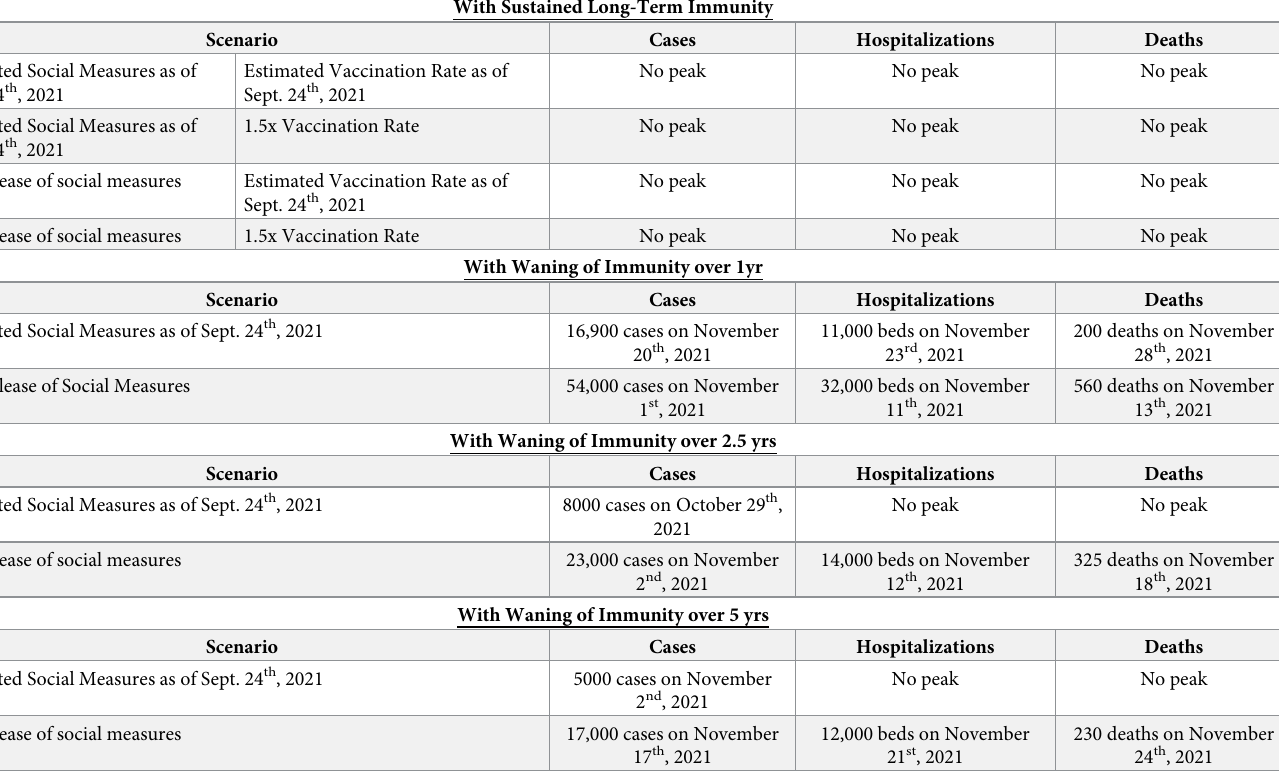
Table 2. Peak cases, hospitalizations,